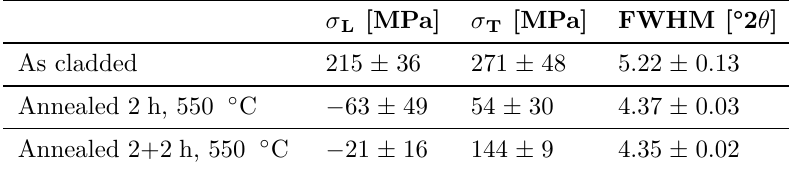
Table 2. Results of surface RS and FWHM of the clad.